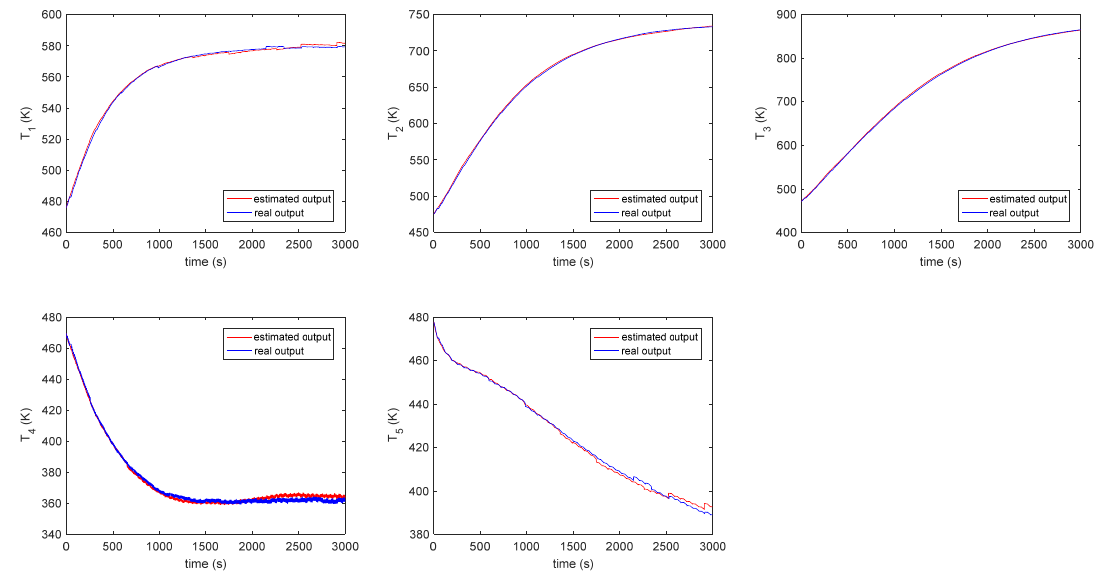
Figure 5. Temperatures in five vessels: blue and red lines indicate the measured outputs and simulated outputs from the LPV model, respectively.